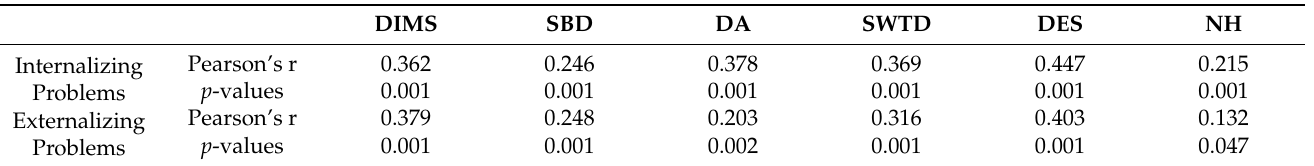
Table 3. Pearson correlation coefficient (r) and p -values for correlation between Sleep Disturbances Scale for Children subscales and CBCL broadband scales